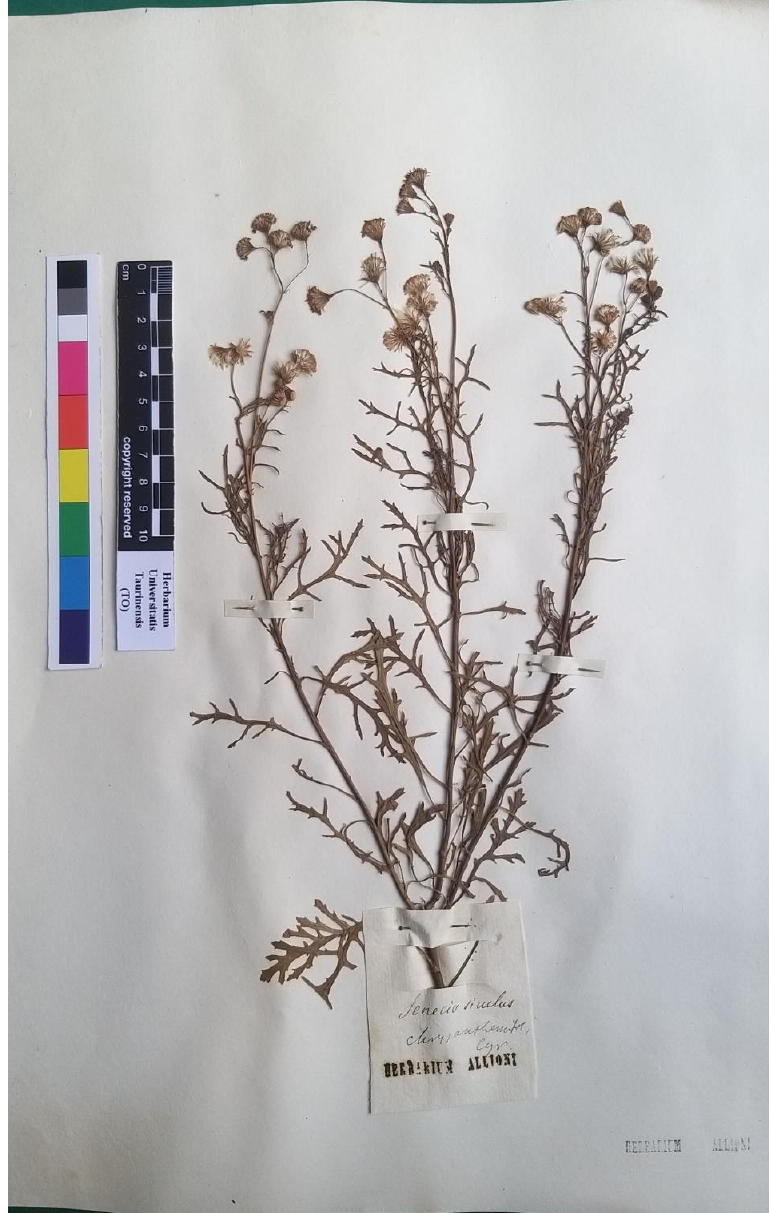
Figure 6. The specimen conserved in the Herbarium Allioni, TO, here designated as lectotype of the name Senecio siculus All. (photo reproduced with permission).